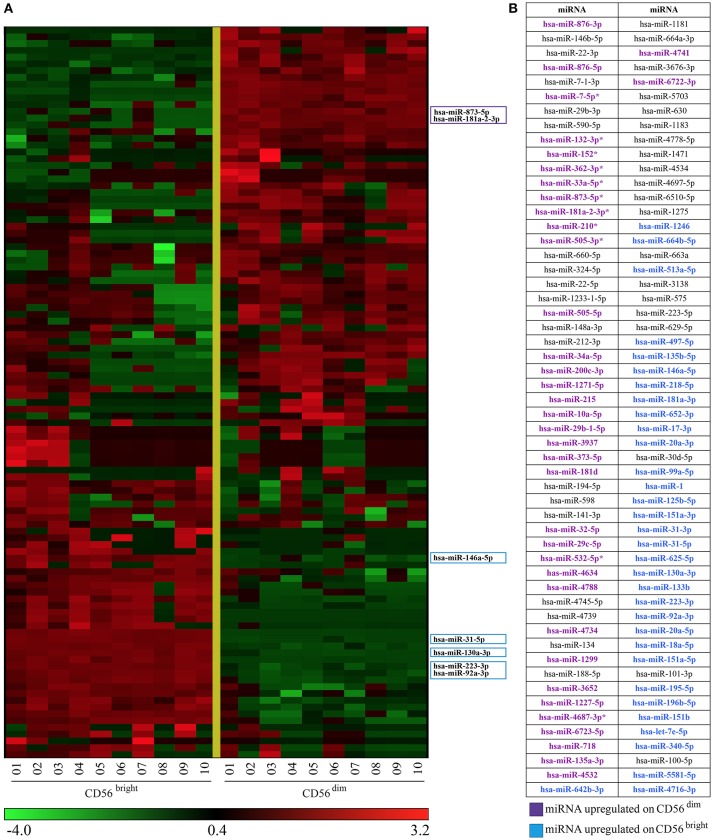
Heatmap representing CD56bright/CD16− and CD56dim/CD16+ NK cells miRNAs signature obtained with multivariate statistical method. (A) Heatmap of the 108 miRNAs signature identified by the l1l2-penalized regularization method. Colored boxes indicate 7 of the most regulated miRNAs. (B) miRNAs listed in (A) (from top to bottom) are indicated. Color legend: the most up-regulated miRNAs on CD56bright/CD16− are indicated in light blue and the most up-regulated miRNAs on CD56dim/CD16+ NK cells are indicated in purple.